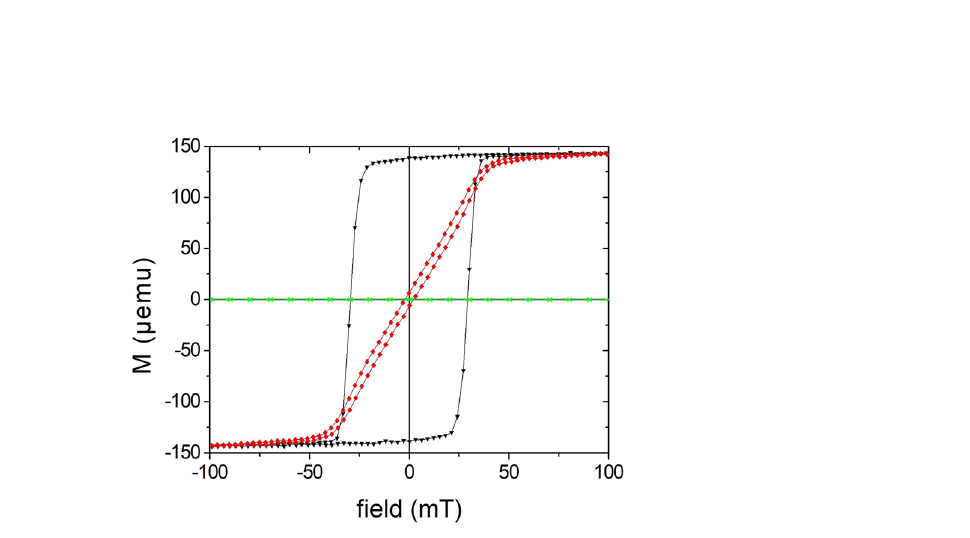
Figure 4. Magnetic hysteresis curve of an ellipses array with 7 nm NiFe thickness with field in-plane along the long (black)/short (red) axis and out-of-plane